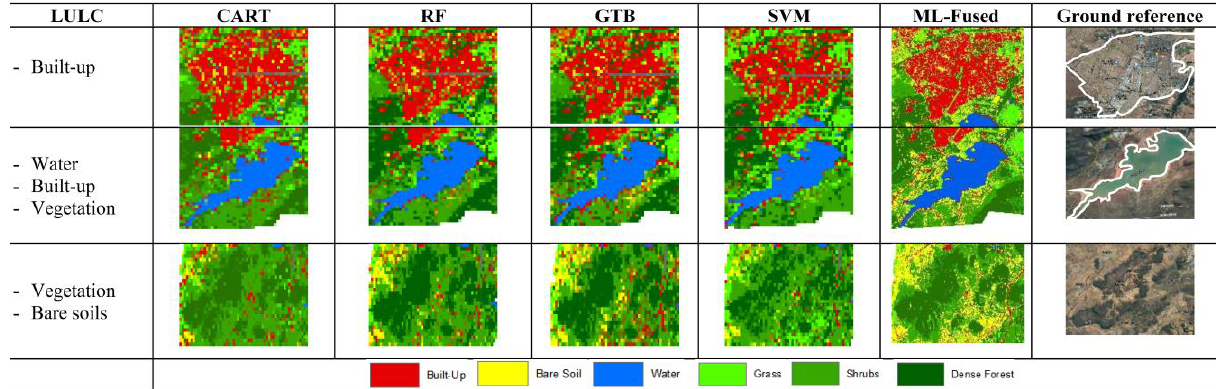
Figure 13 . Image based ground-truth comparison of classification results for different LULC classes and at different locations within the study area for